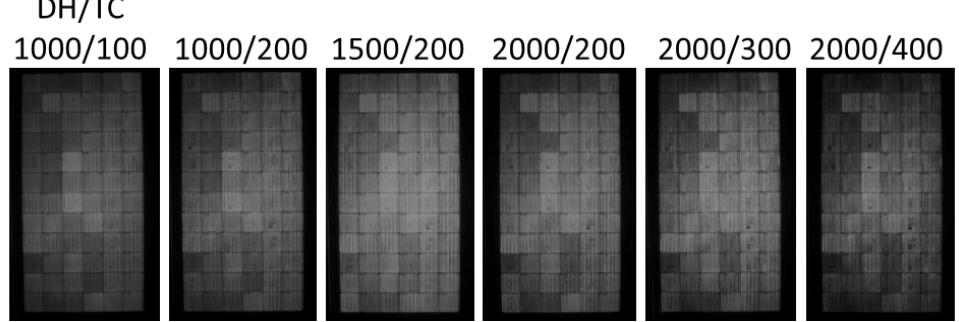
Figure 9. Electroluminescence images of modules with respect to combined DH-TC test sequences.